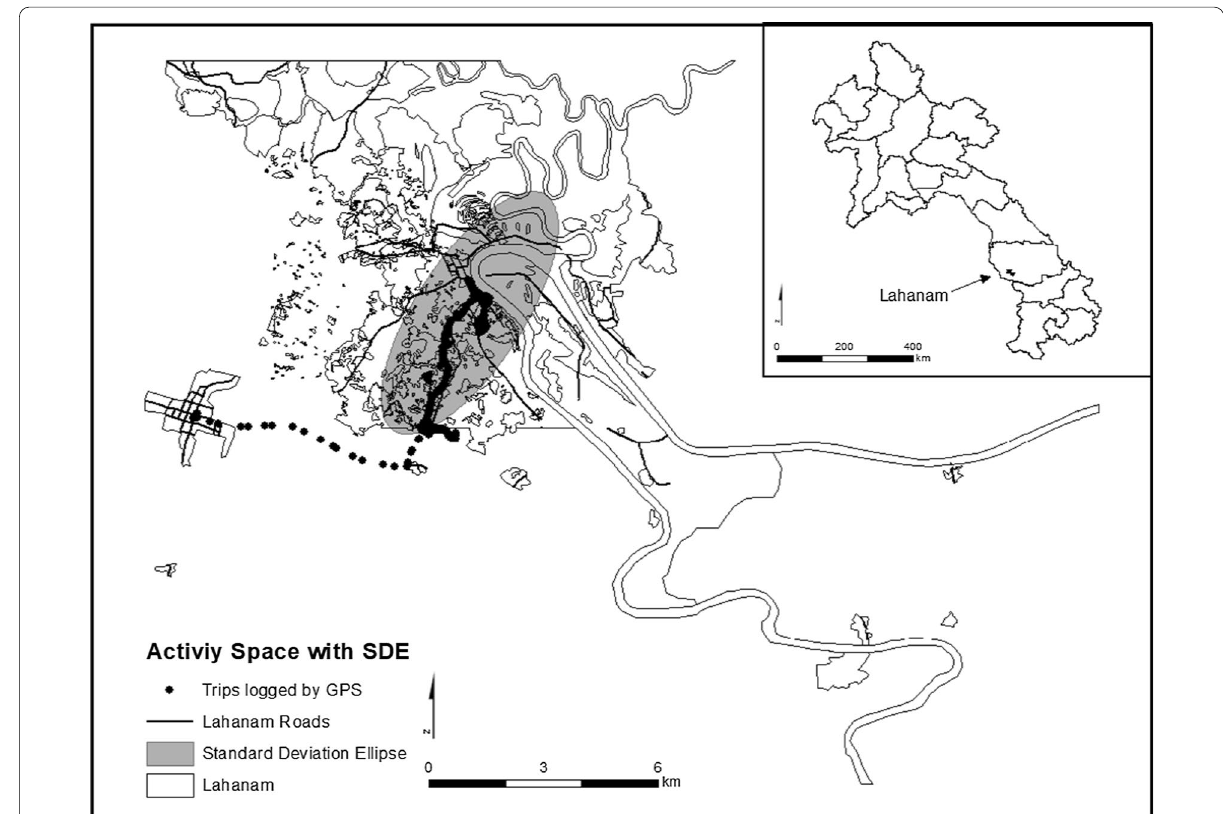
Fig. 2 Example of a participant’s daily activity movement with a 2-standard deviation ellipse representing the participant’s activity space shaded in gray (This map was created by the